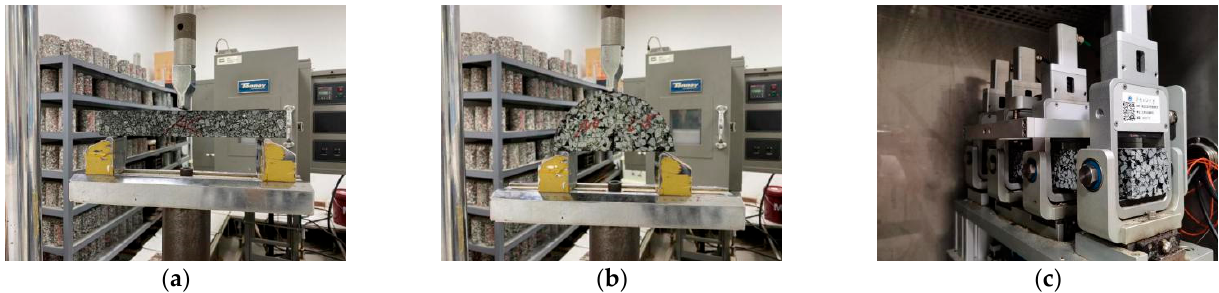
Figure 3. Anti-cracking performance tests: ( a ) low temperature bending test and impact toughness test; ( b ) semicircular bend test (SCB); ( c ) four-point beam fatigue test.